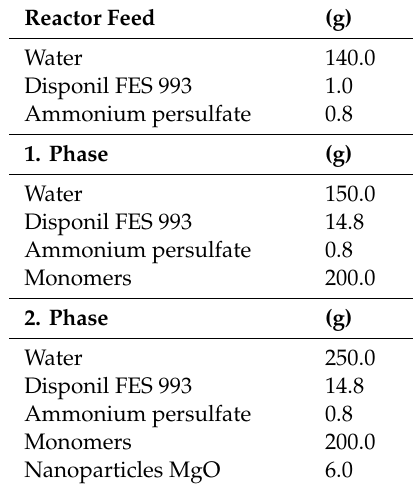
Table 2. Composition of the polymerization